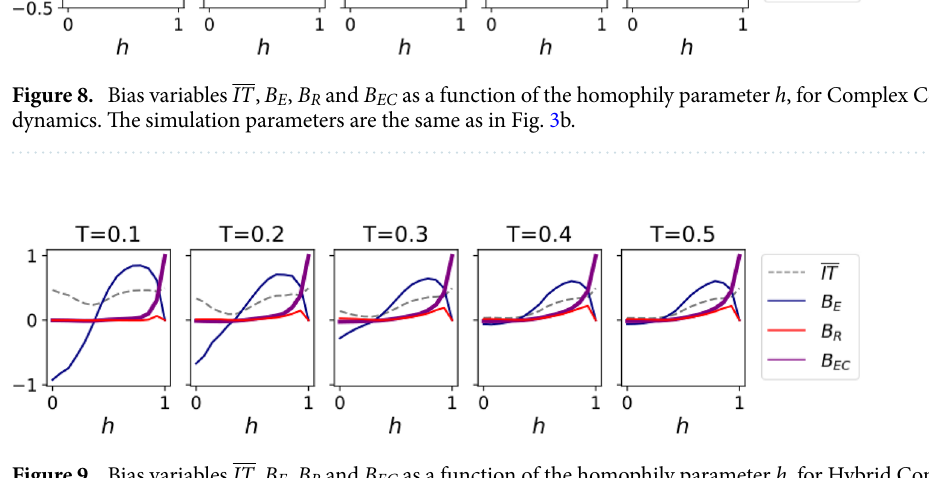
Figure 9. Bias variables IT , B E , B R and B EC as a function of the homophily parameter h , for Hybrid Contagion dynamics. The simulations and parameters are the same as in Fig.